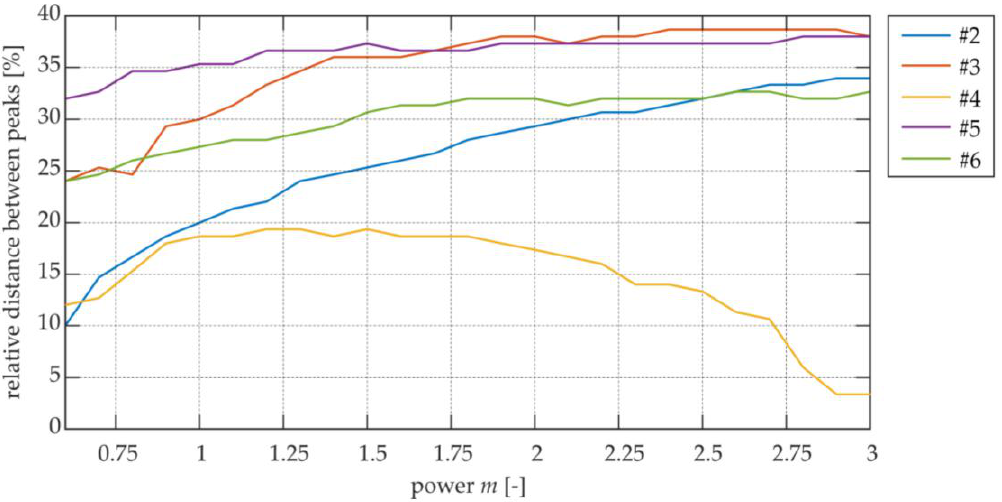
Figure 18. Relationships between the relative peak distance of WRMS histograms and weighting factor (represented by power m ) for specimens #2–#6.